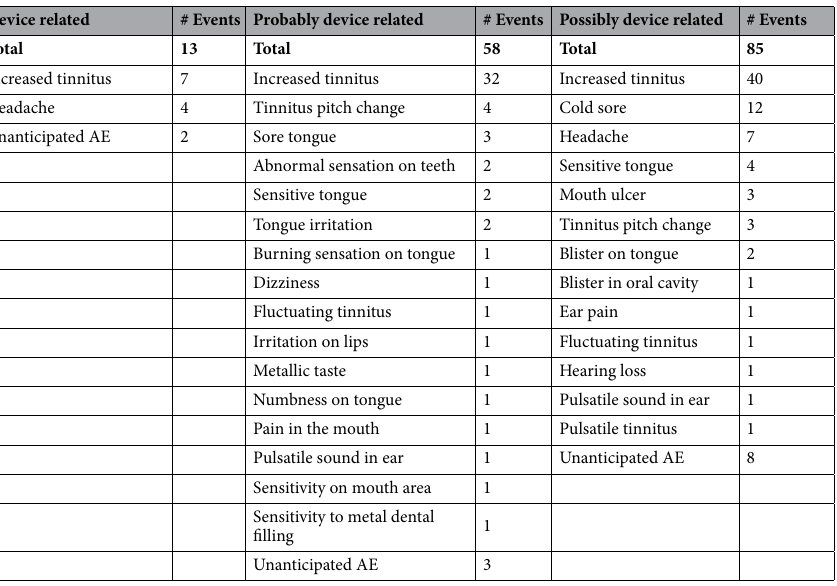
Table 2. Safety data (AEs) recorded throughout the study. There were no treatment related SAEs.